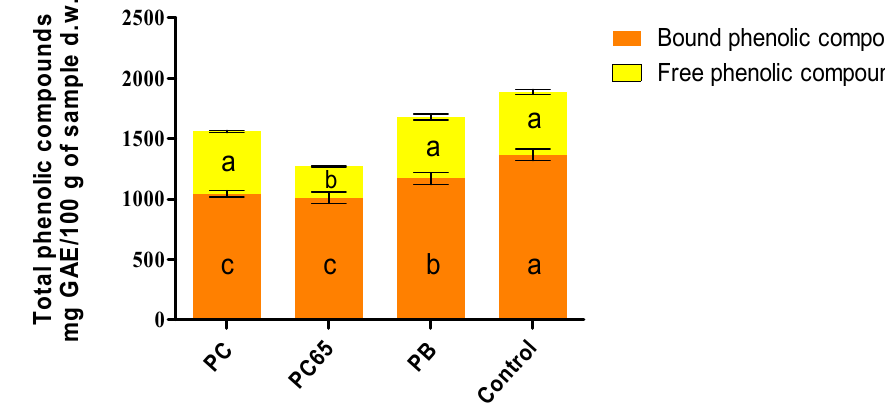
Figure 4. Contents of total, free, and bound phenolic compounds in the energy snacks. Different letters present in the same column color are statistically different ( p < 0.05).